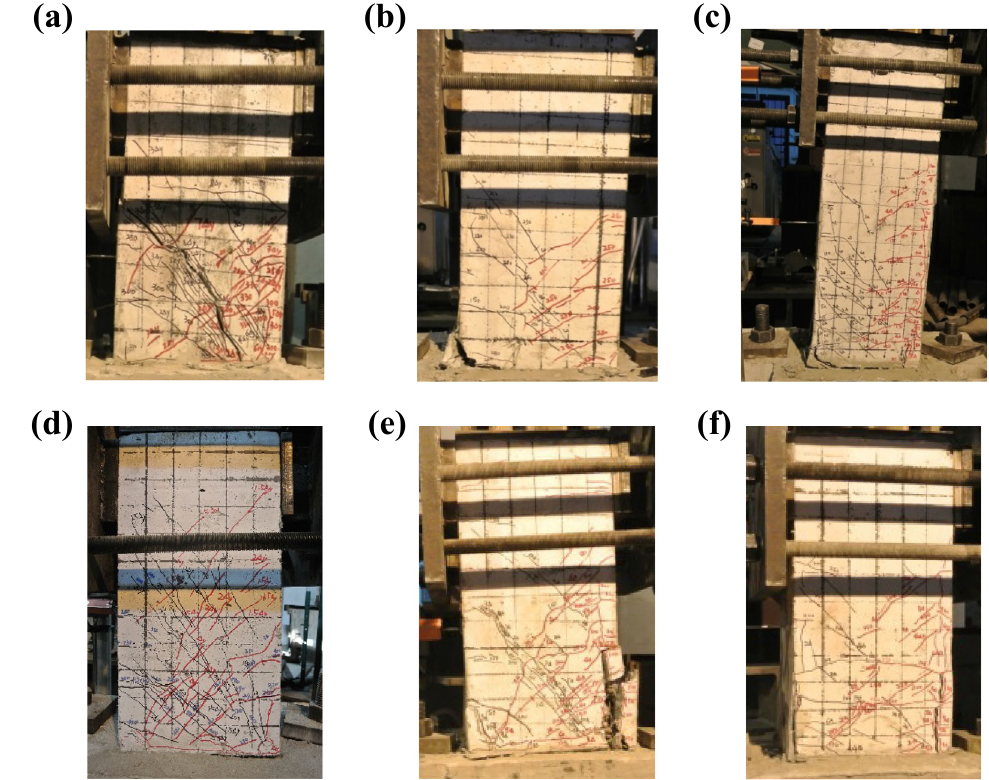
Fig. 9 Crack patterns of specimens at failure. a Specimen E1, b Specimen E2, c Specimen E3, d Specimen E4, e Specimen E5 and f Specimen E6.